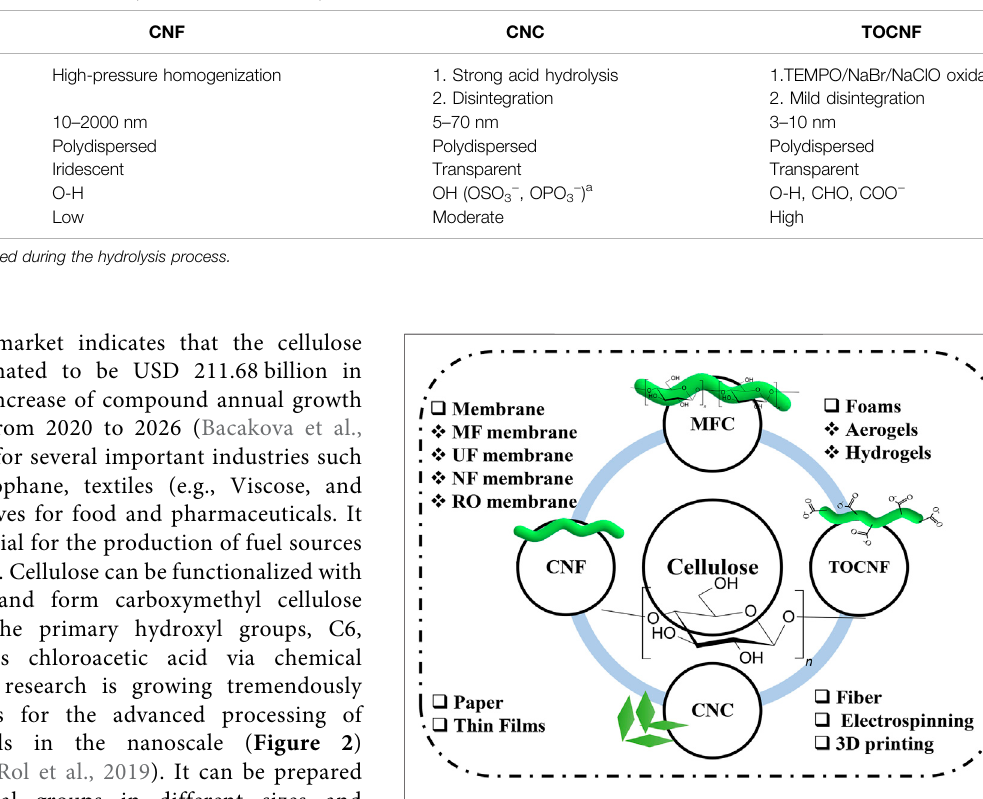
TABLE 1 | Comparison of cellulose nanomaterials (CNF, CNC, and TOCNF).